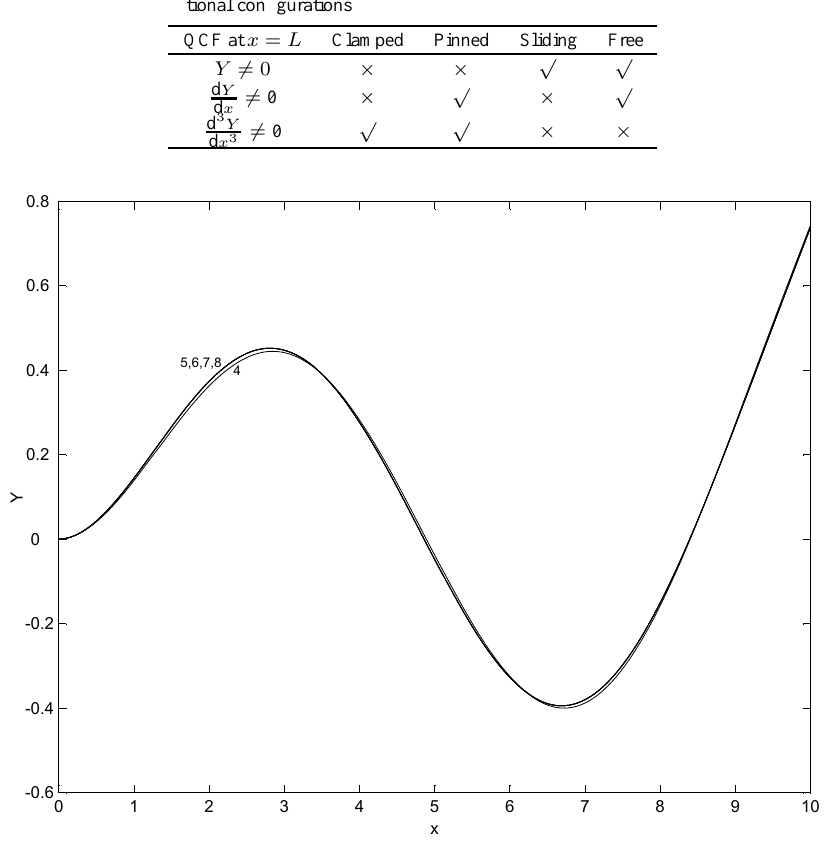
Table 1 Required conditions in QCF and satisfaction by conven-